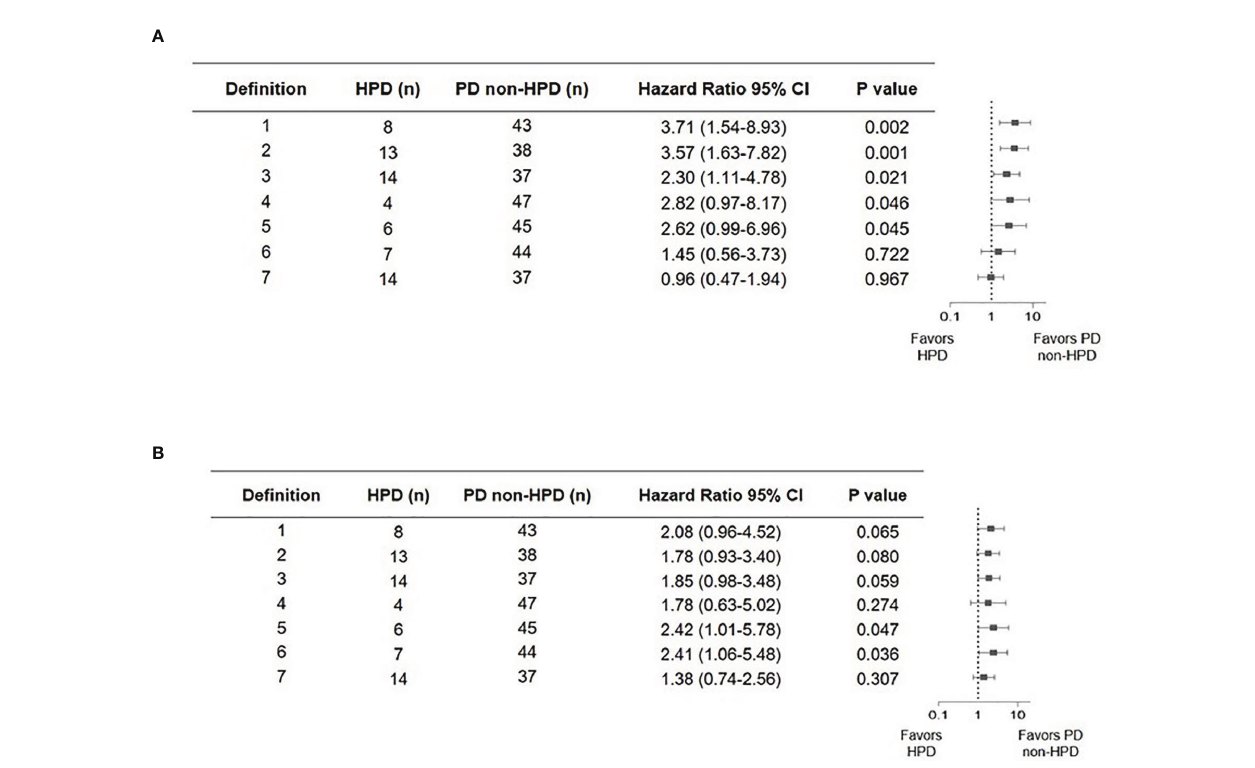
FIGURE 2 | Forest plot of hazard ratios from comparison of overall survival (A) and progression-free survival (B) in patients who experienced hyperprogressive disease versus those who experienced progressive but not hyperprogressive disease with seven de fi nitions. Squares represent hazard ratio (HR). Horizontal lines indicate the 95% CIs. HPD, hyperprogressive disease; CI, con fi dence interval.